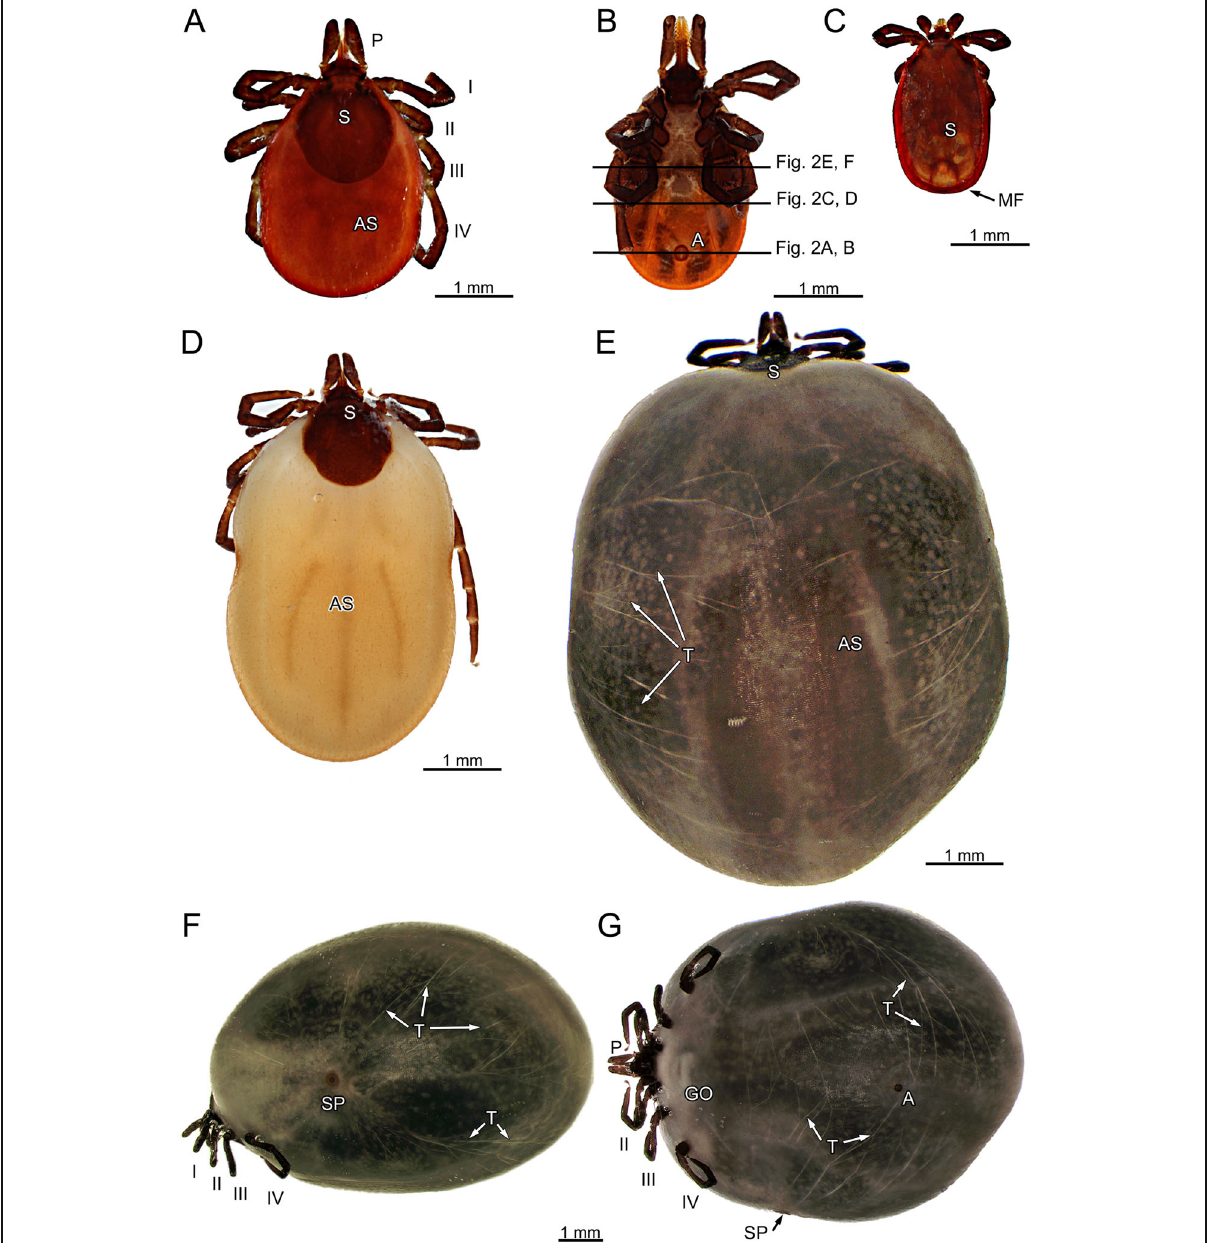
Fig. 1 Ixodes ricinus . a Fasting female, dorsal view. b Fasting female, ventral view; black lines indicate positions of histological sections shown in Fig. 2a, c, and e and μ CT-imaging Fig. 2b, d, and f, respectively. c Fasting male, dorsal view. d Semi-engorged female, dorsal view. e Fully engorged female, dorsal view. f Fully engorged female, lateral view. g Fully engorged female, ventral view. Abbreviations : A, anus; AS, alloscutum; GO, genital opening; MF, marginal fold; P, pedipalp; S, scutum; SP, spiracular plate; T, Tracheae; I – IV,